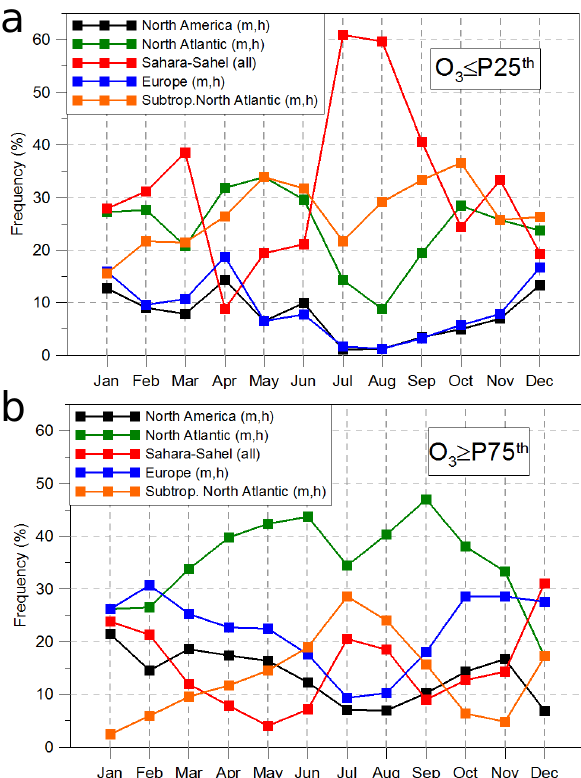
Fig. 8. (a) PM 10 (µm − 3 ) vs. surface O 3 (ppbv) at IZO for winter (JFM), spring (AMJ), summer (JAS) and autumn (OND) in the pe- riod 2002–2009. (b) 210 Pb (mBqm − 3 ) vs. surface O 3 (ppbv) for the same seasons in the period 1988–1991. Surface O 3 daily nocturnal data have been grouped in 10ppbv bin ranges from the minimum to maximum value. Each point of the plot represents the median value of surface O 3 concentrations associated to the mean values of PM 10 or 210 Pb in a determined bin range. The standard deviation of the mean (SDOM) associated to PM 10 and 210 Pb mean values is represented by horizontal bars.